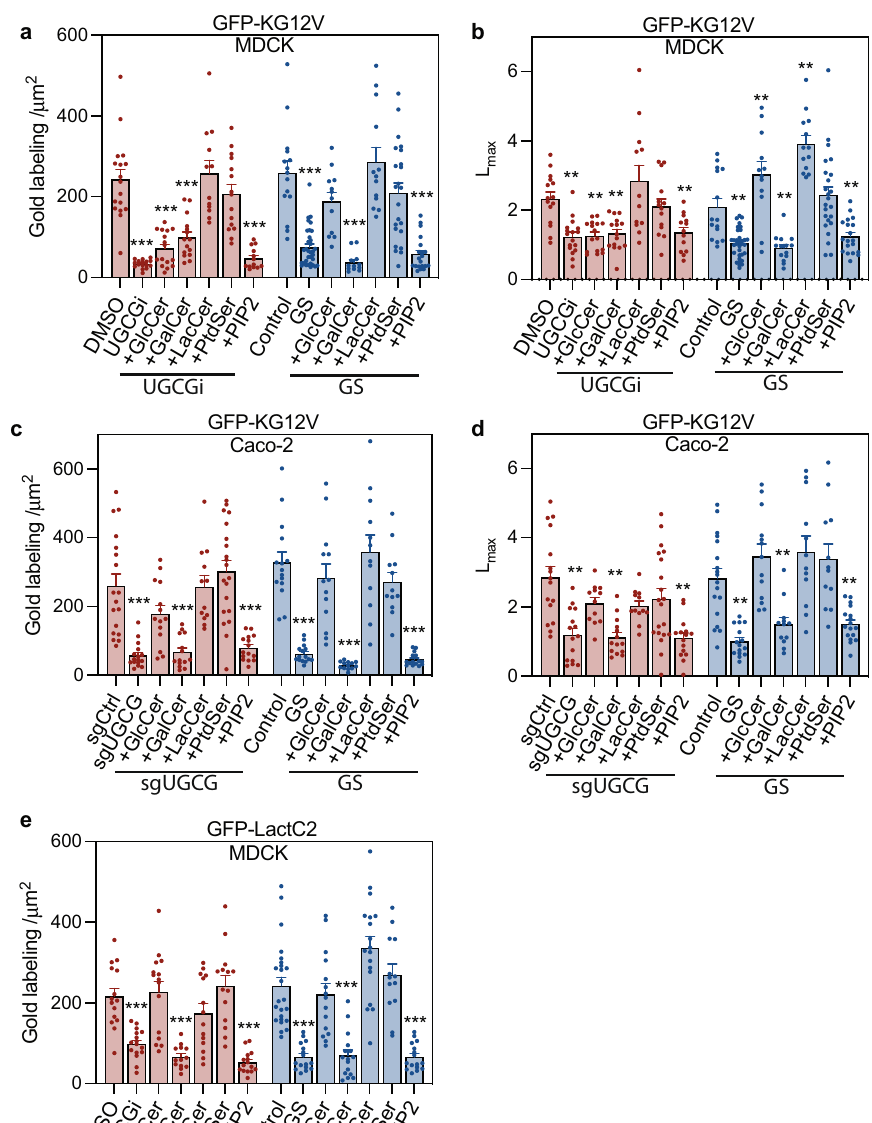
Fig. 2 | GSLs are required for KRAS plasma membrane localization. a , b KRASG12V-expressing MDCK cells (KG12V) treated with 25 μ M DL-PDMP (UGCGi) (24h, ( n =14 PM sheets), or cultured in glucose-depleted (GS) medium (4h, n =16) and incubated with exogenous GalCer ( n =13), GlcCer ( n =15), LacCer ( n =14), PtdSer ( n =14) or PIP 2 ( n =14) for 1h were evaluated using EM. KRASG12V PM binding was quanti fi ed as mean gold labeling density and nanoclustering as L max . Comparisons are with cognate untreated control cells. c , d Identical GSL